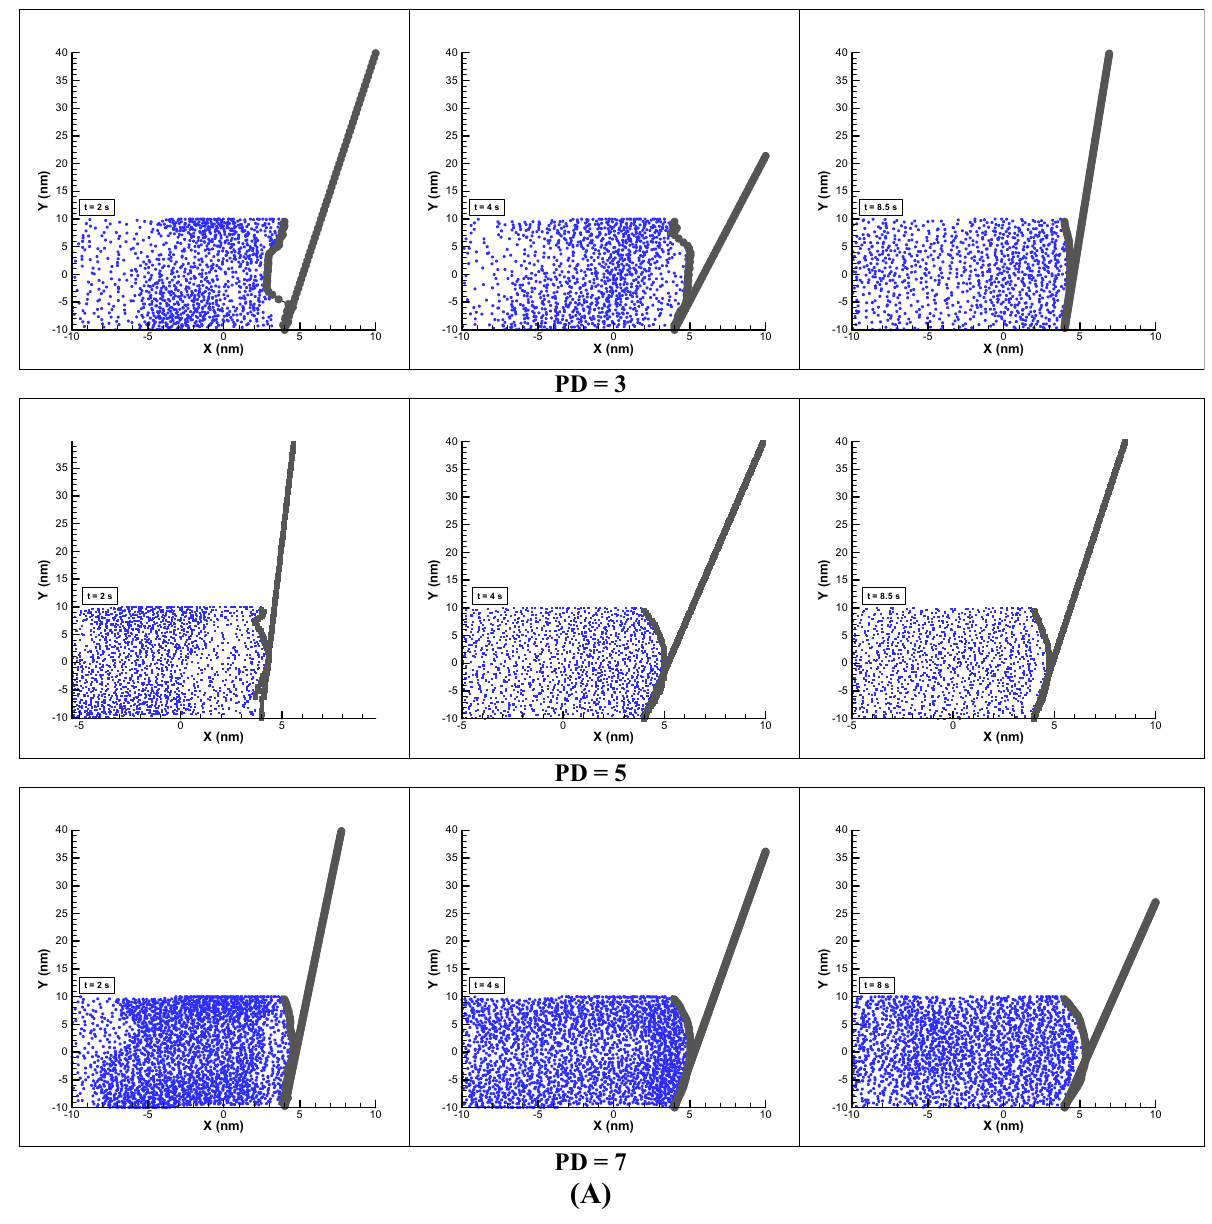
Figure 11. Effect of particles density (PD) on membrane. Displacement of polymer chain in EOF for different PD ( A ). Changes of radius of gyration and VACF over dimensionless time (t/t max ) considering different PD ( B